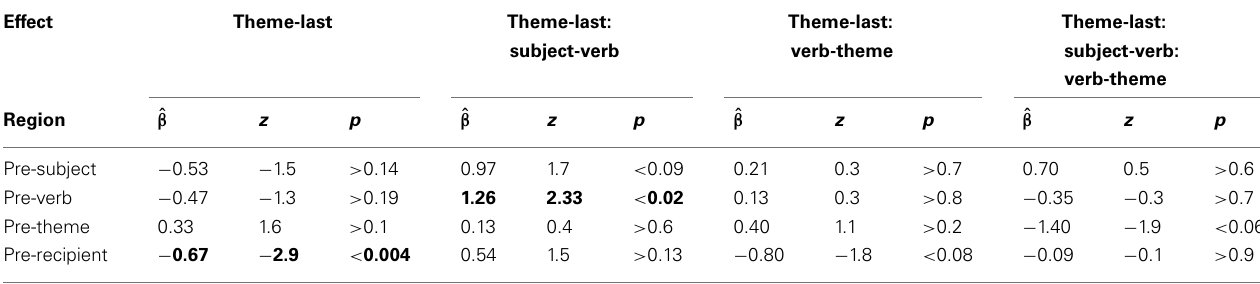
TableA1 | Interactions between post-verbal constituent order and phonological overlap on fluency by sentence region.